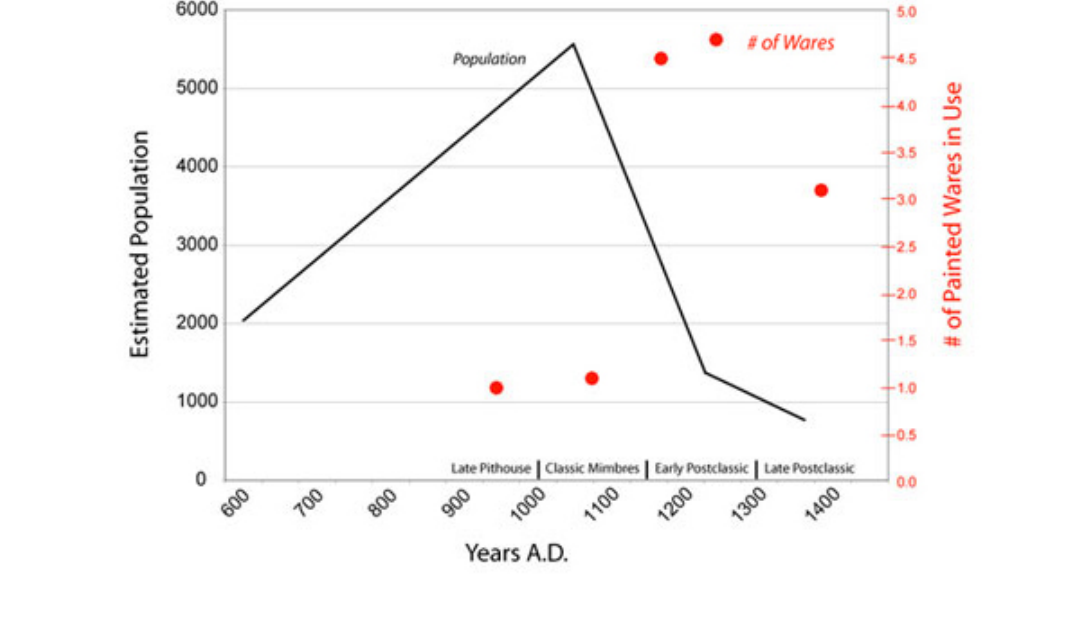
Fig. 2 . Population change and associated changes in painted ceramic diversity in the Mimbres